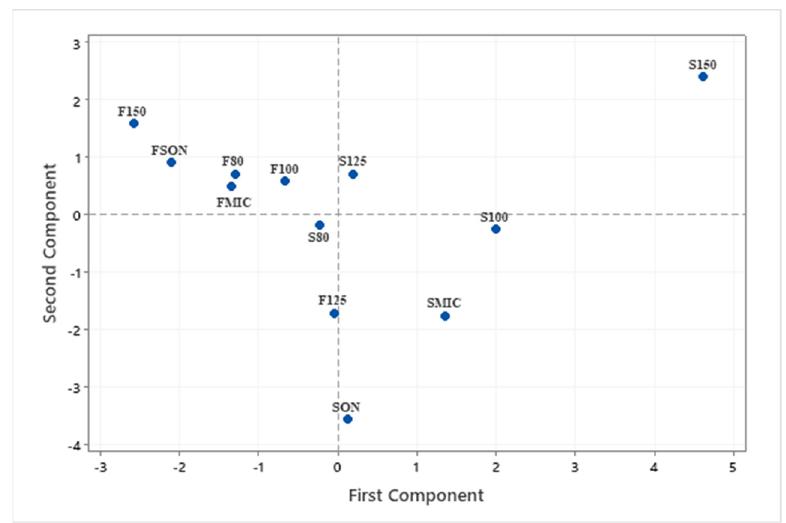
Figure 2. Score plot highlighting effect of extraction method on extract composition. Effect of the phenolic compounds on the components.